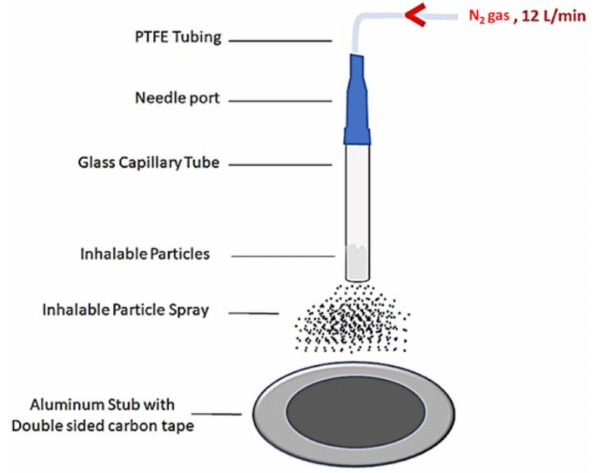
Figure 2. A simple air-flow particle disperser for depositing microparticles onto SEM sample holder for imaging and determining